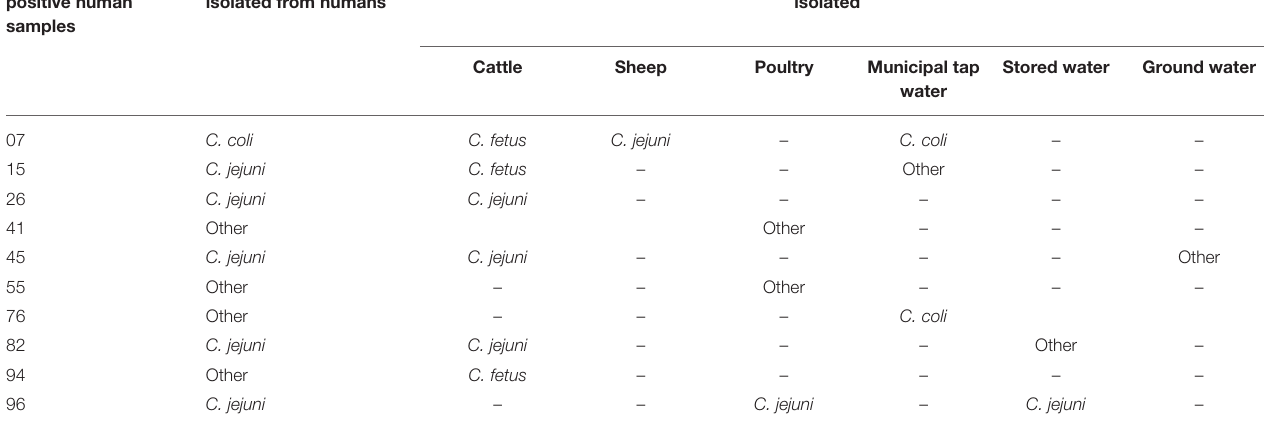
TABLE 2 | Co-occurrence of similar Campylobacter species in human, animals, and water samples within households. HHc of Campylobacter positive human